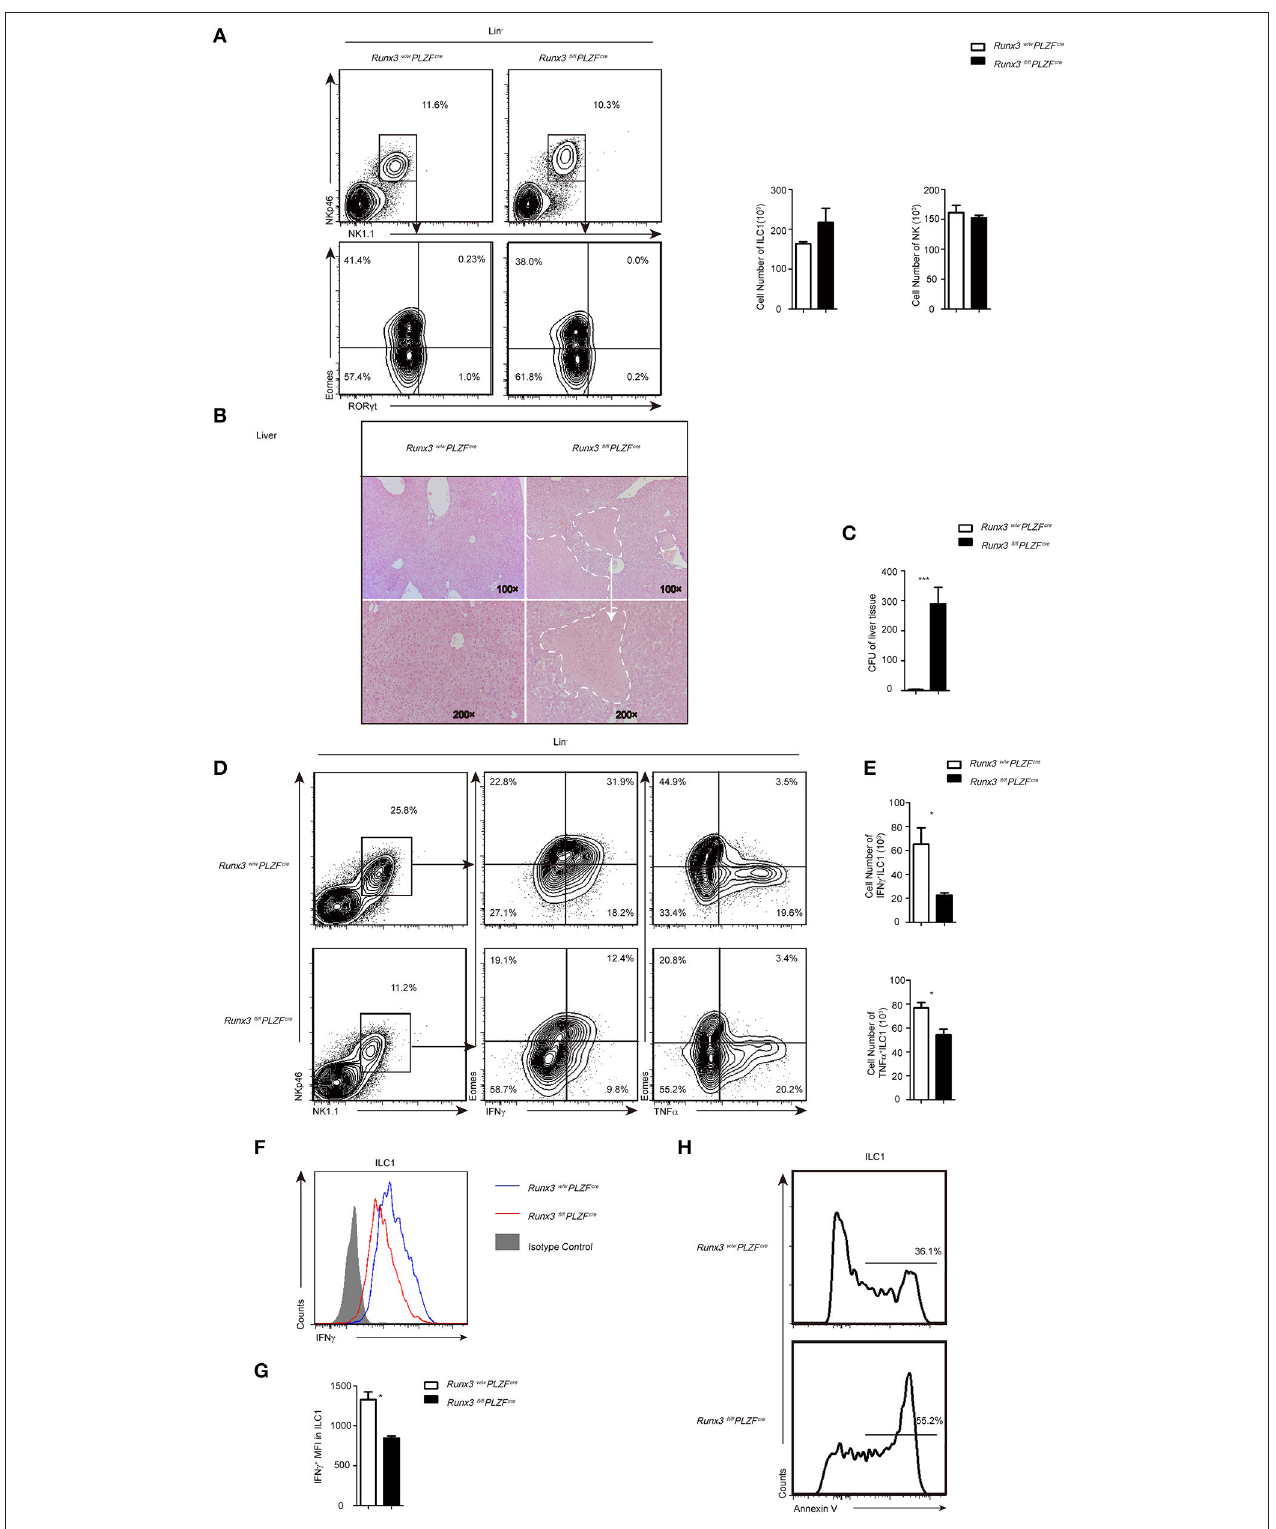
FIGURE 2 | Increased sensitivity to L. monocytogenes infection partially due to defective ILC1 function after Runx3 deletion. (A) Flow cytometry analysis of the percentage of ILC1s and NK cells in the liver from control and cKO mice before infection, and absolute cell number of the indicated ILC population. (B–H) Control